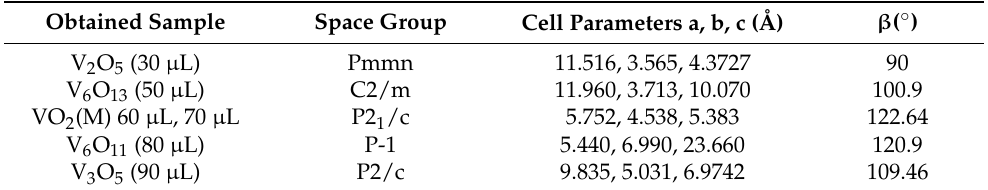
Figure 1. ( a – f ) XRD patterns of hydrothermal samples with different amounts of the reductive reagent N 2 H 4 ·H 2 O at 260 °C and 24 h duration. Table 1. The crystallography data of the obtained phases with different amounts of the reductive reagent.